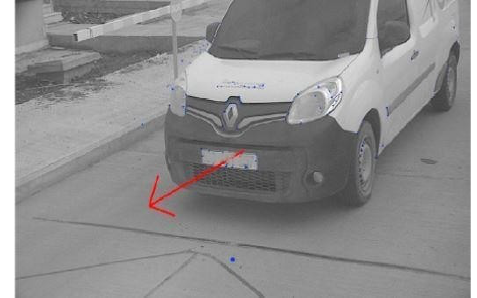
Fig. 10: Resultant motion (Red arrow) and feature locations (Blue dot)